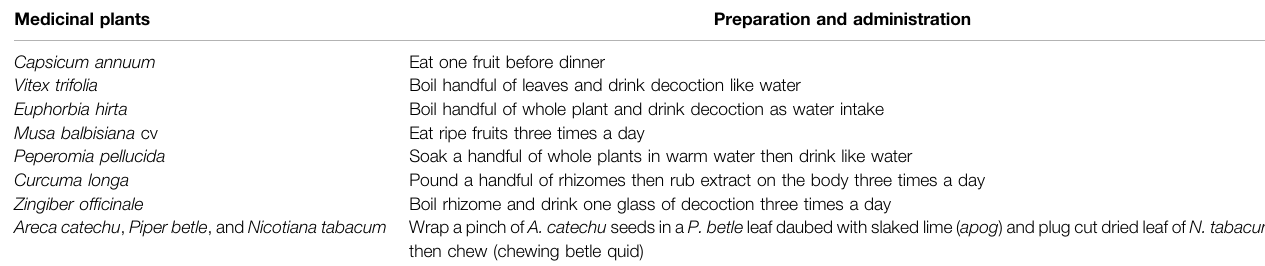
TABLE 4 | Medicinal plants used to strengthen immunity against infection. Medicinal